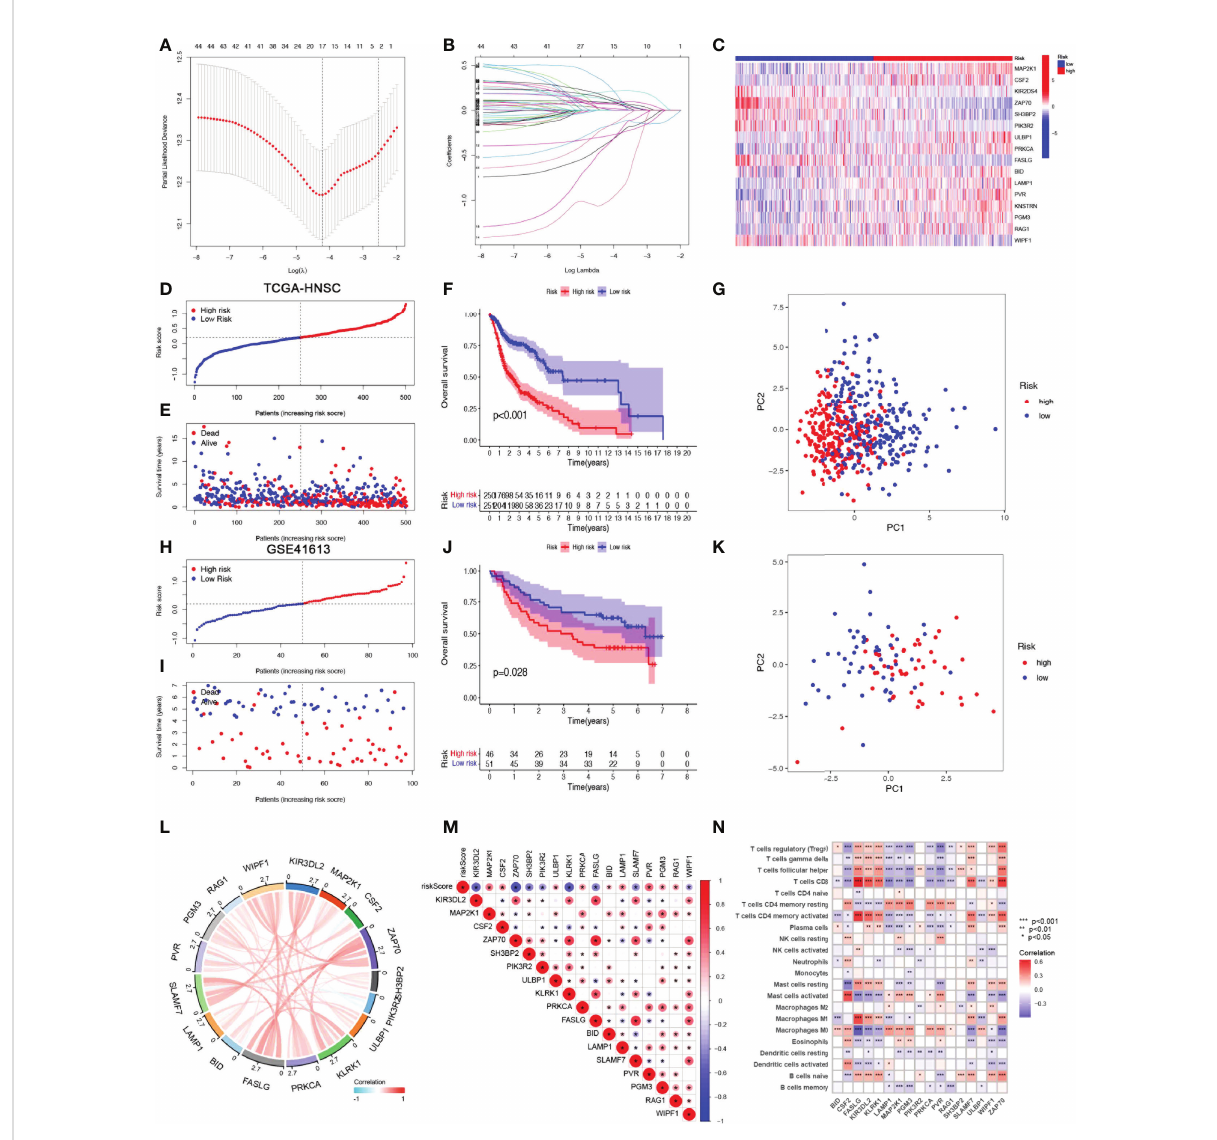
FIGURE 3 Construction and validation of NRGs Signature. (A) Ten ‐ time cross ‐ validation for tuning parameter selection in the LASSO model. (B) LASSO coef fi cient pro fi les. (C) Heat map of risk factors in high- and low-risk patients. (D) Distribution of risk scores between low- and high-risk groups in the TCGA group. (E) Survival status of HNSCC patients in the low- and high-risk groups in the TCGA group. (F) (KM curve compares the overall HNSCC patients between low- and high-risk groups in the TCGA cohort. (G) PCA plot in the TCGA cohort. (H) Distribution of risk scores between low- and high-risk groups in the GEO cohort. (I) Survival status of HNSCC patients in the low- and high-risk groups in the GEO cohort. (J) KM curve compares the overall HNSCC patients between low- and high-risk groups in the GEO cohort. (K) PCA plot in the GEO cohort. (L) Correlation analysis and co-expression heat map of 17-NRGs. (M) Correlation of 17 NRGs with riskscore (N) Correlation analysis of 17 NRGs with immune